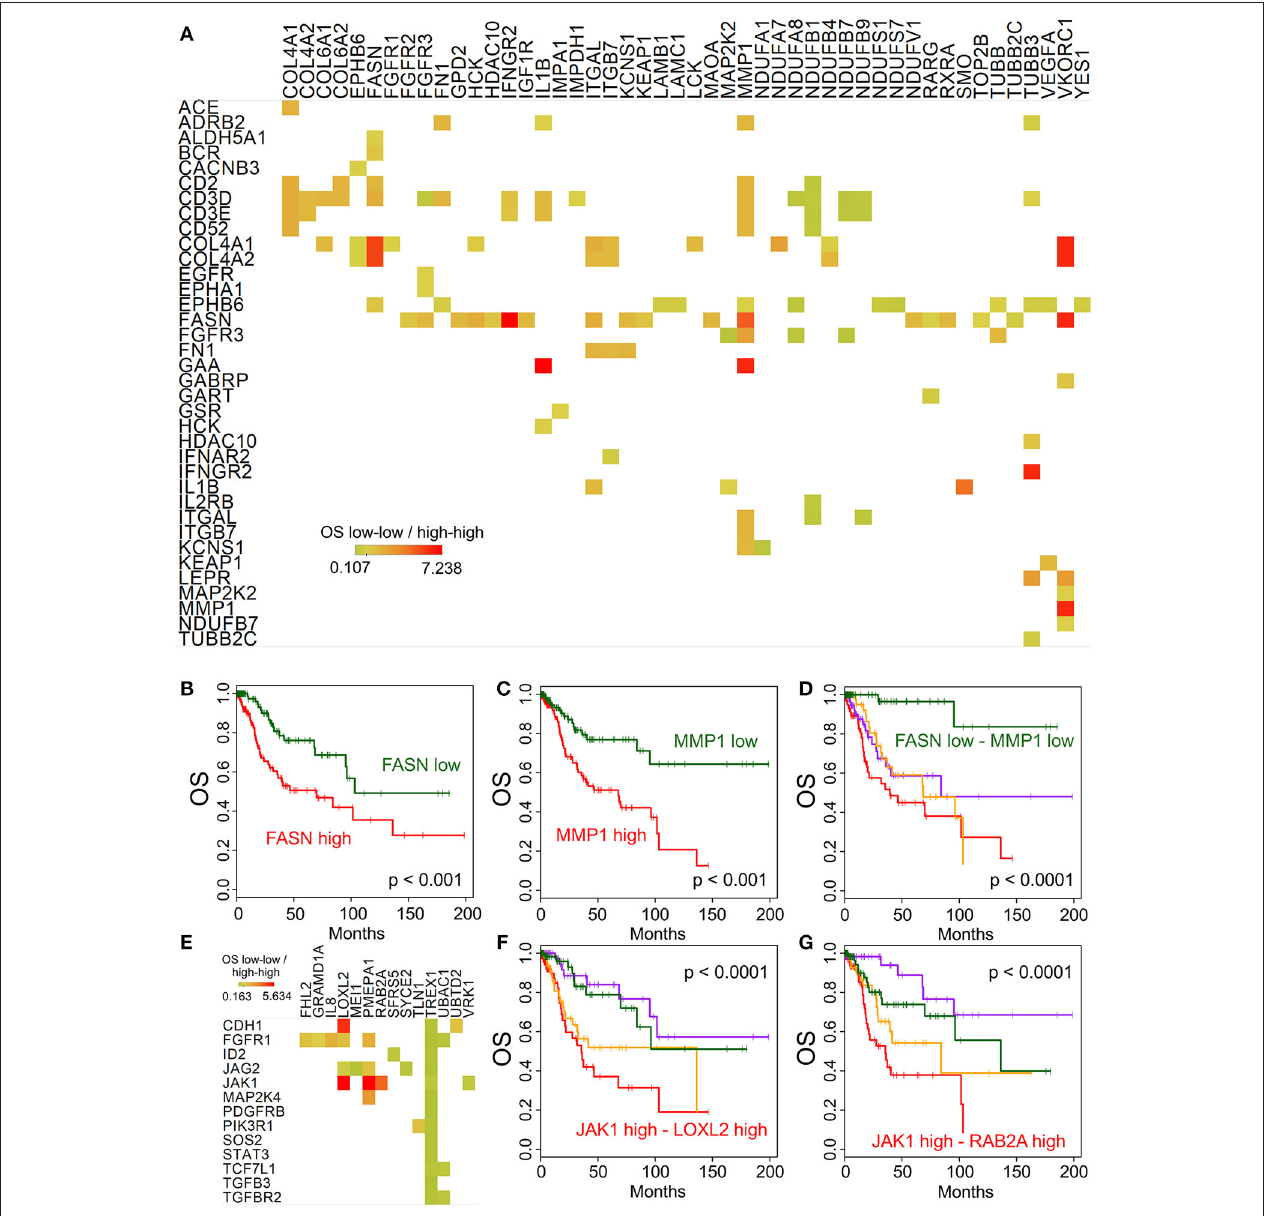
FIGURE 5 | Potential targets for combination therapies. Median overall survival ratio of low-low (both below median) and high-high (both above median) expression of gene pairs is depicted as shown by the color legend (A) , only p < 0.0001 associations where median expression > 5 TPM). Kaplan-Meier plots show the difference between high and low expression for FASN (B) and MMP1 (C) alone, and in combination (D) . (E) Displays the overall survival ratio analysis results for the EMT genes (shown in rows) identified by our Ingenuity Pathway Analysis. The JAK1 - LOXL2 (F) and JAK1 - RAB2A (G) combination survival analyses are shown as